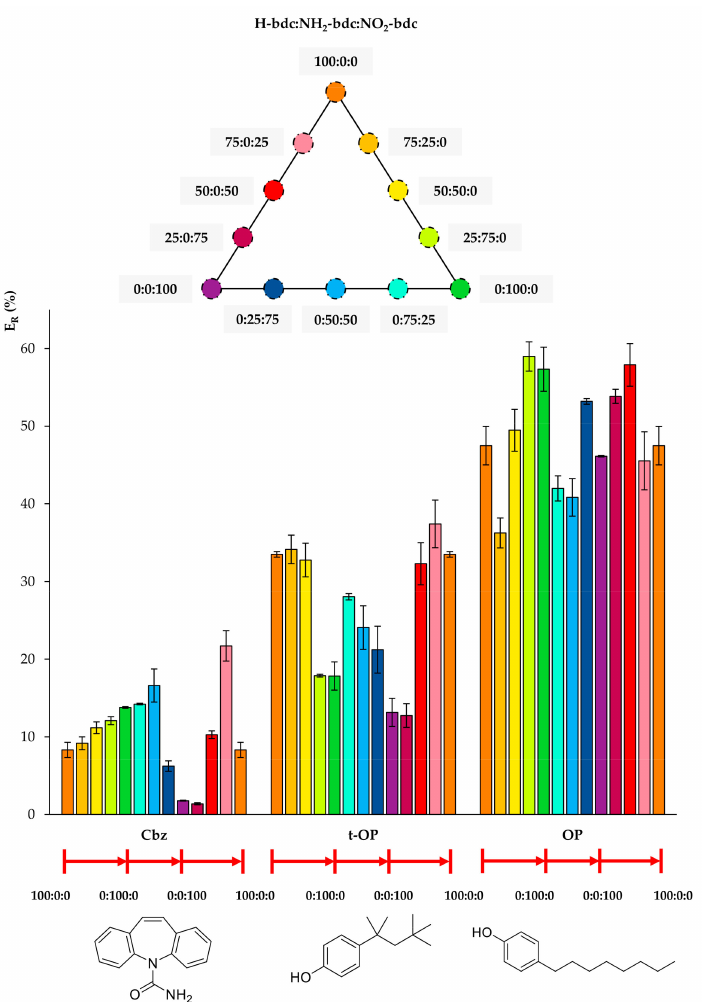
Figure 4. Extraction e ffi ciencies (E R in %) using the twelve UiO-66-based MOFs as sorbents in D- µ SPE-HPLC-DAD for the analytes carbamazepine (Cbz), 4-tert-octylphenol (t-OP), and 4-octylphenol (OP) (selected for presenting similar